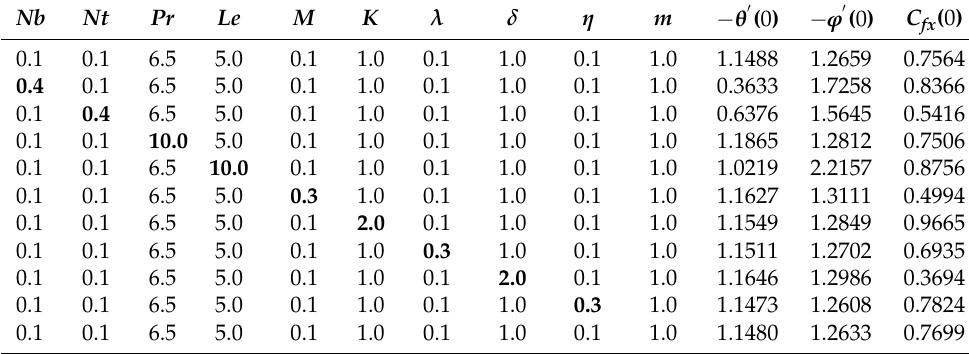
Table 2. Values of − θ (cid:48) ( 0 ) , − φ (cid:48) ( 0 ) and C fx ( 0 ) .